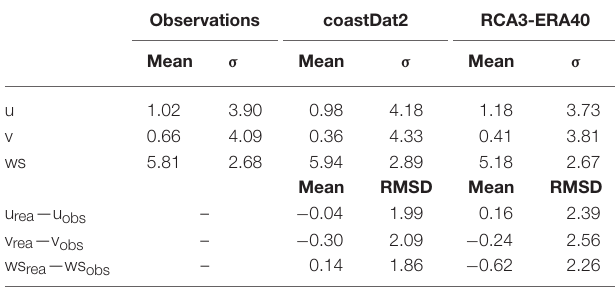
TABLE 3 | Mean zonal wind speed (u), meridional wind speed (v), and total wind speed (ws) with their standard deviations ( σ ) for observations, coastDat2, and RCA3-ERA40 dataset as well as mean and root mean square difference (RMSD) between the reanalysis datasets (rea) and the observations (obs) for zonal, meridional, and total wind speed.